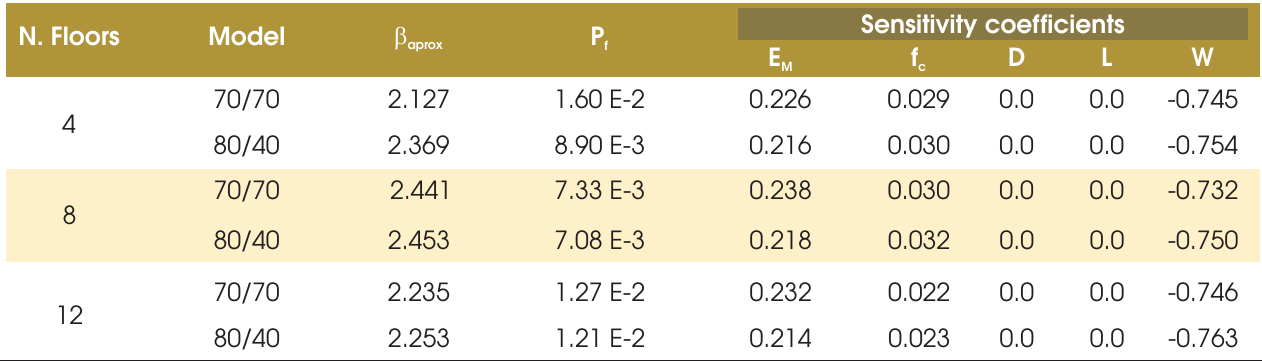
Table 7 – Results for 50-year extreme wind load combined with arbitrary-point-in-time life load N.